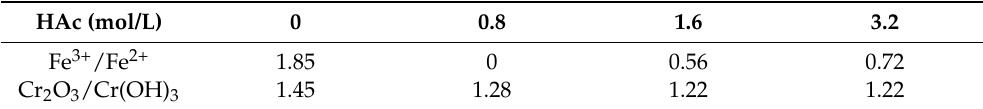
Table 4. The ratios of Fe 3+ /Fe 2+ and Cr 2 O 3 /Cr(OH) 3 , calculated from the XPS spectra in the solutions with